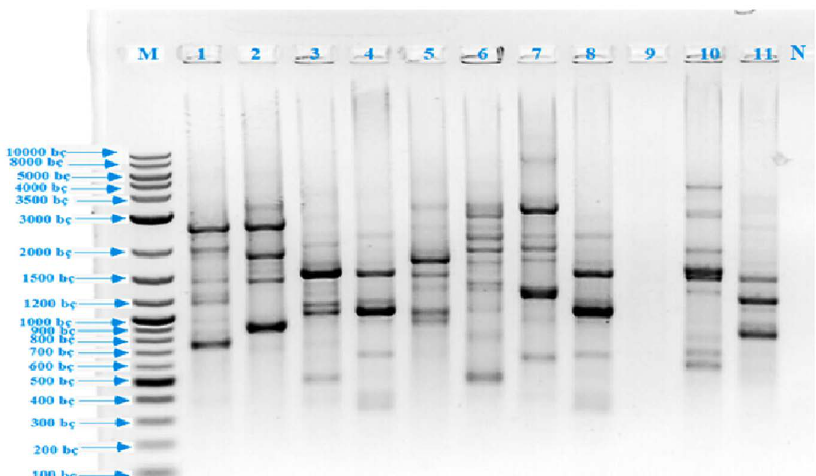
PCR band profiles of thermophilic isolates (M: DNA Marker, 1: EA 10, 2: EA 6, 3: EA 5, 4: EA 3, 5: EA Fig. 1. (GTG) 5 9, 6: EA 11, 7: EA 1, 8: EA 7, 9: EA 4, 10: EA 8, 11: EA 2, 12: Negative